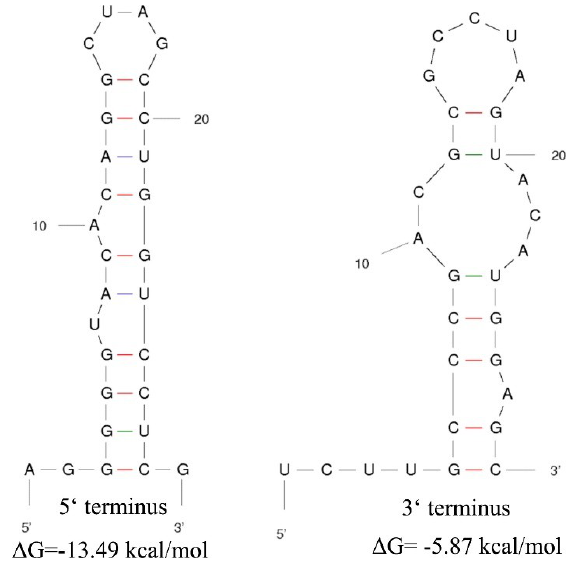
Figure 3. Potential secondary structures of the 5’ and 3’ termini of MOLV4. The putative stem-loop